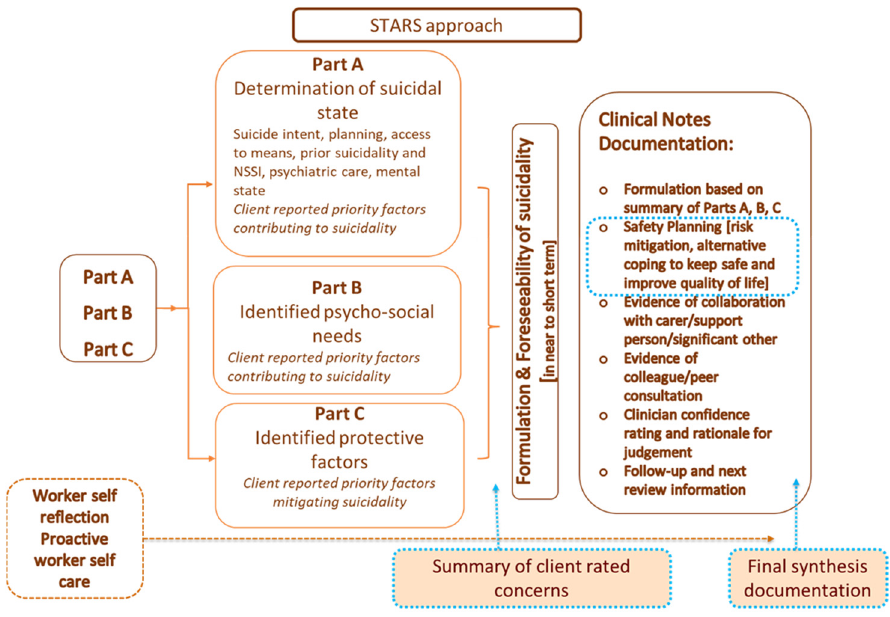
Figure 1. The STARS protocol (from Hawgood et al. [10]).